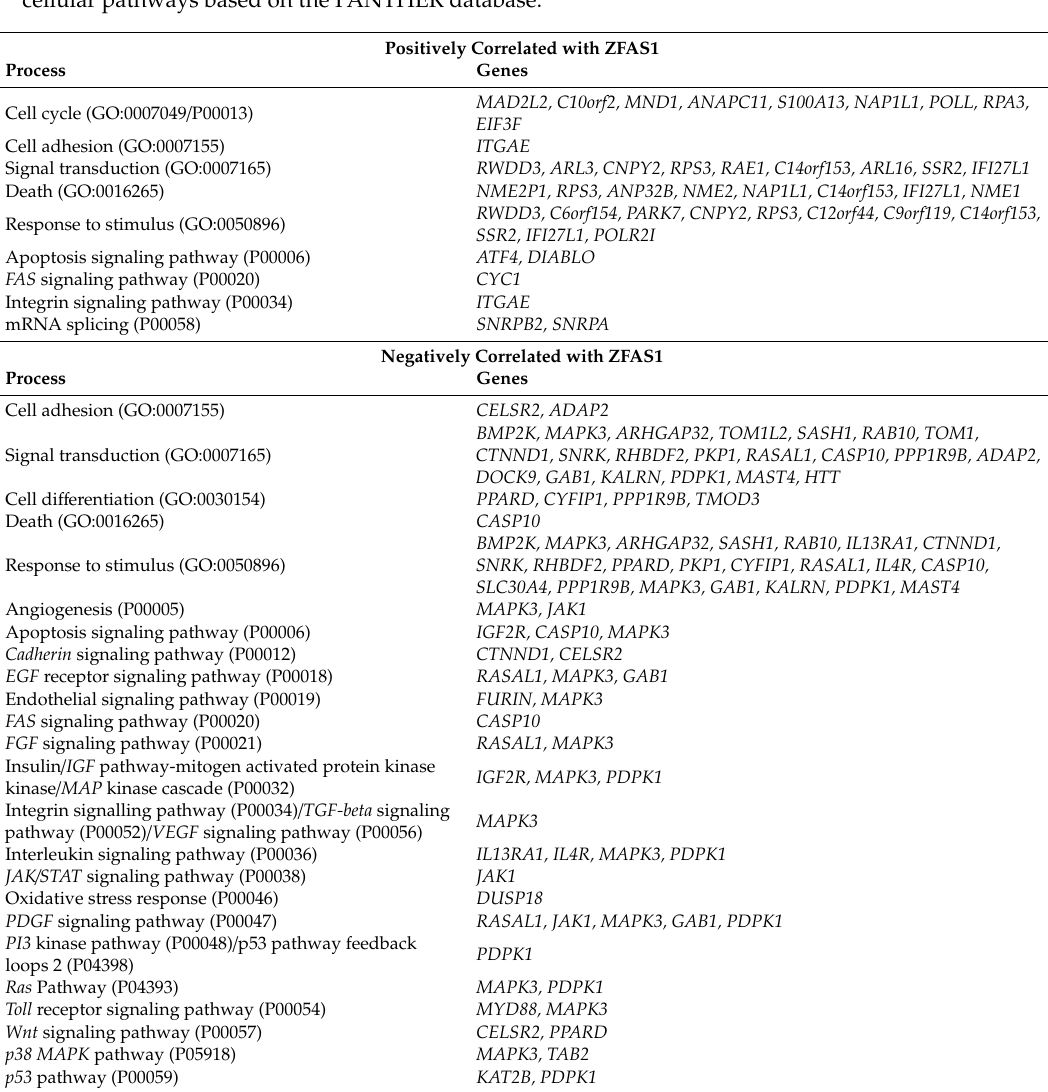
Table 2. Classification of the genes positively and negatively correlated with ZFAS1 expression (Pearson correlation >+ 0.3 or < − 0.3, respectively) in HNSCC patients into specific biological processes and cellular pathways based on the PANTHER